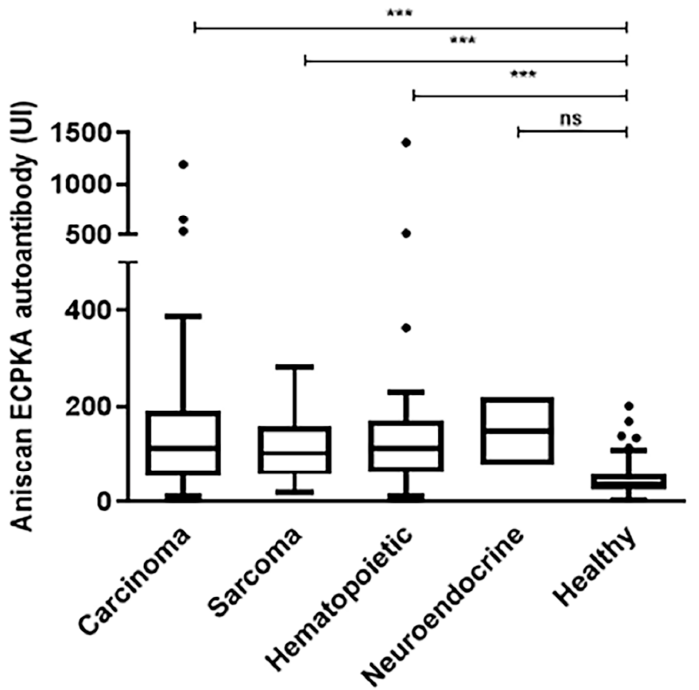
Figure 4. Box and whisker plot of AniScan ECPKA autoantibody levels in dogs with different